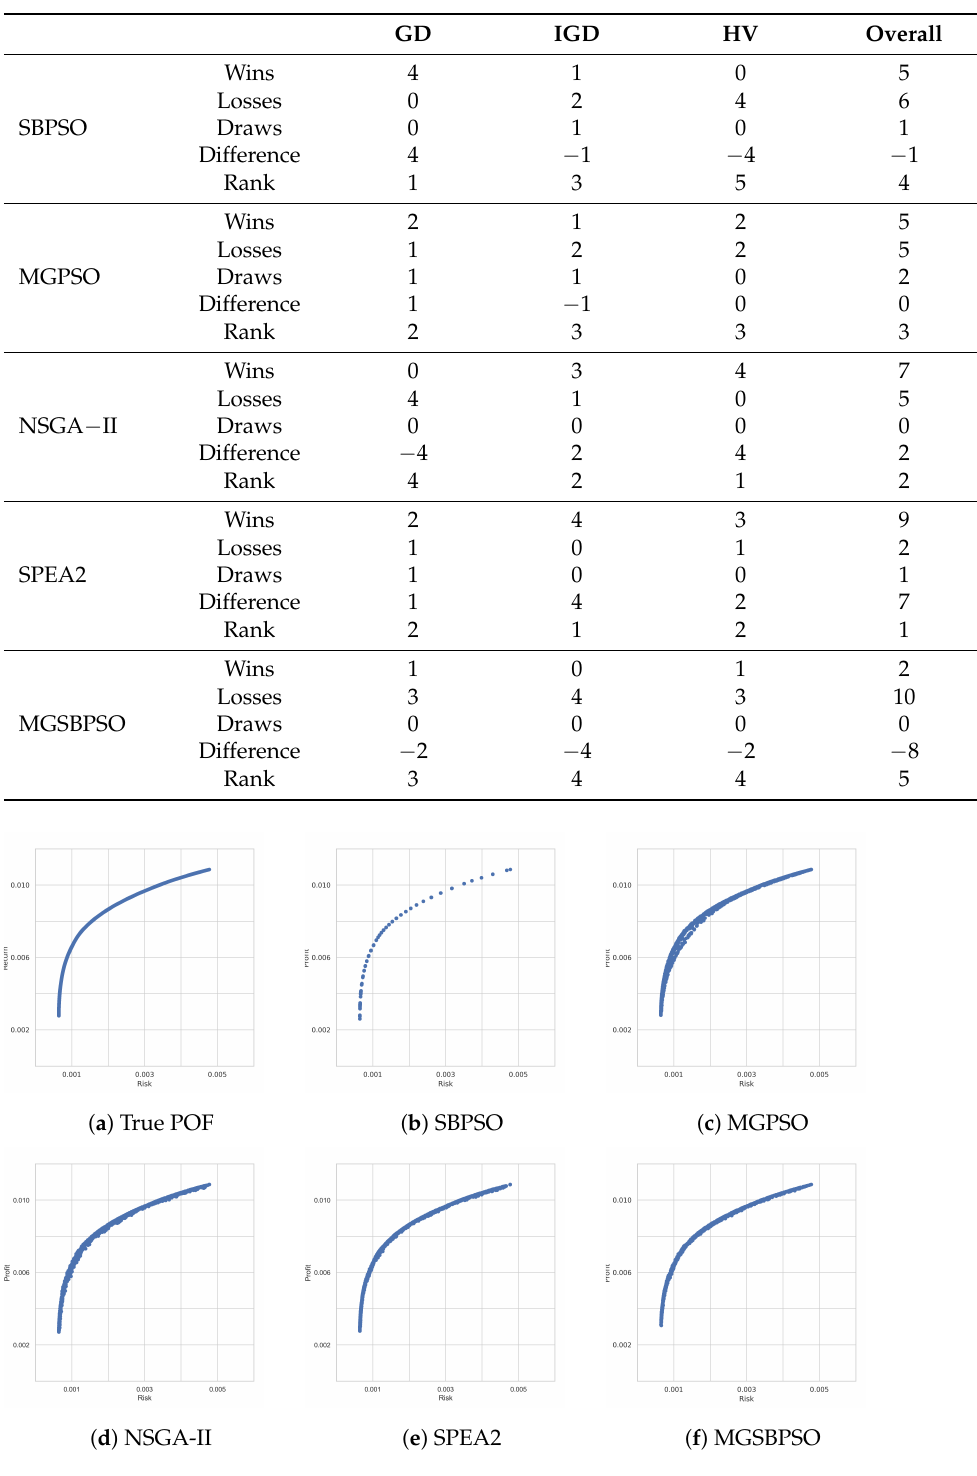
Table 6. Hang Seng rankings for each performance measure.